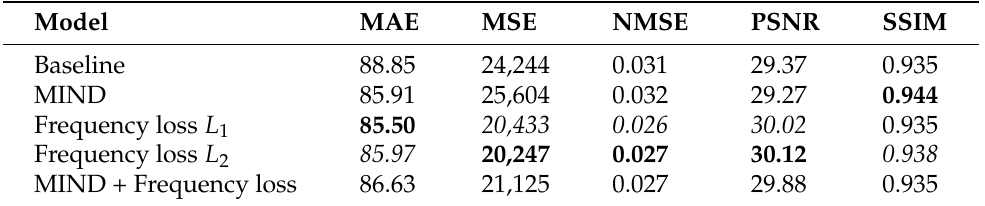
Table 2. Quantitative metrics obtained on the test set for experiments with various structure losses run on the CBCT-CT dataset. All metrics were computed between images with their intensities expressed on the HU scale and clipped into the range [0, 3000]. The best value per metric is highlighted in bold letters and the second best value per metric is